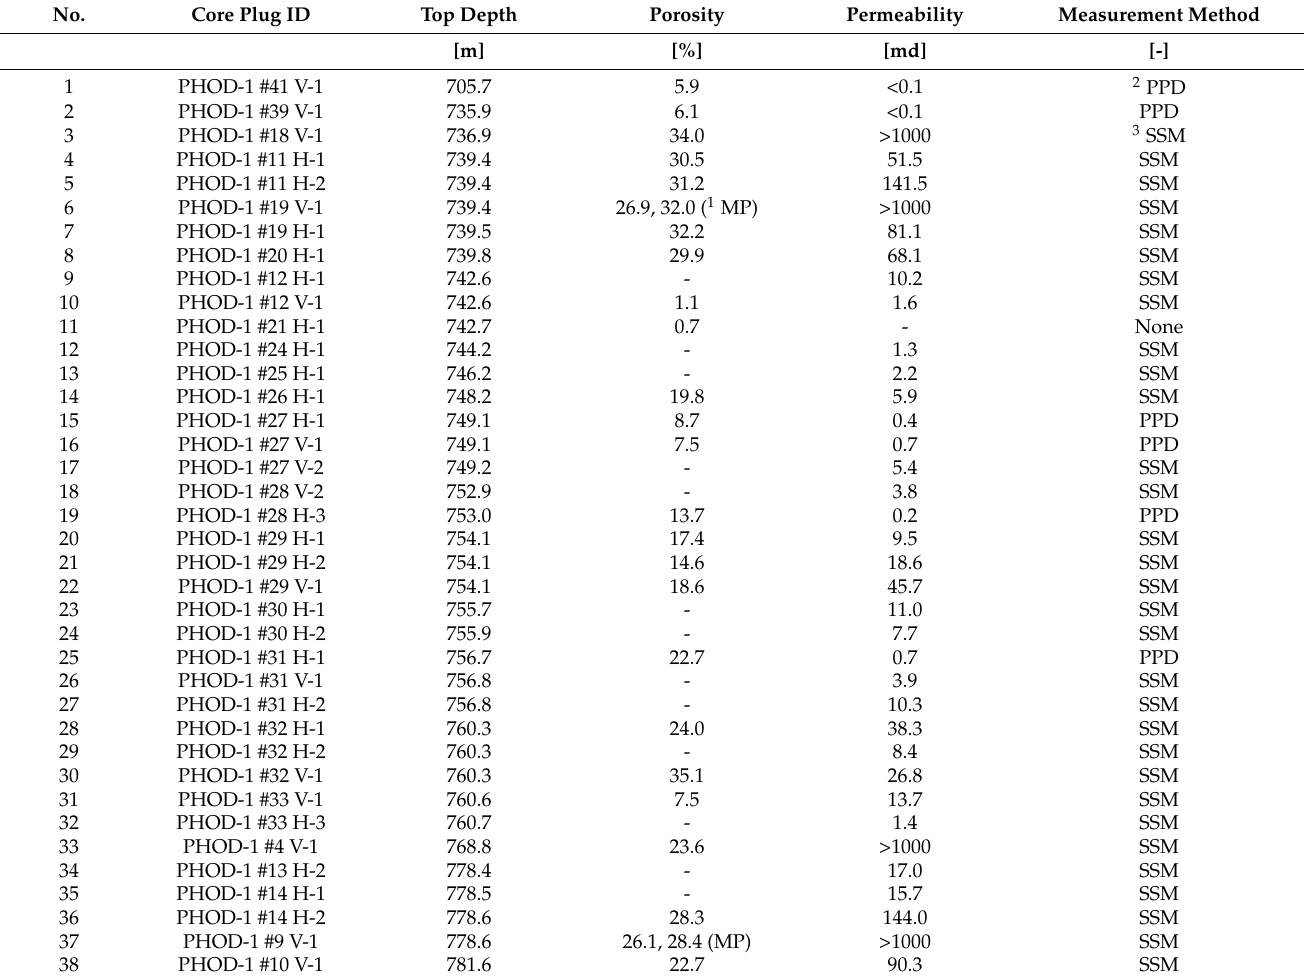
Table A2. Porosity measurements from helium porosimetry and mercury porosimetry and permeability measurements from Pressure Pulse Decay (PPD) and Steady State Methods